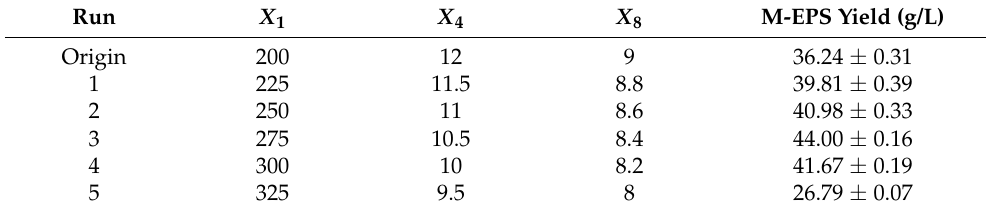
Table 2. Experimental design and results of the steepest